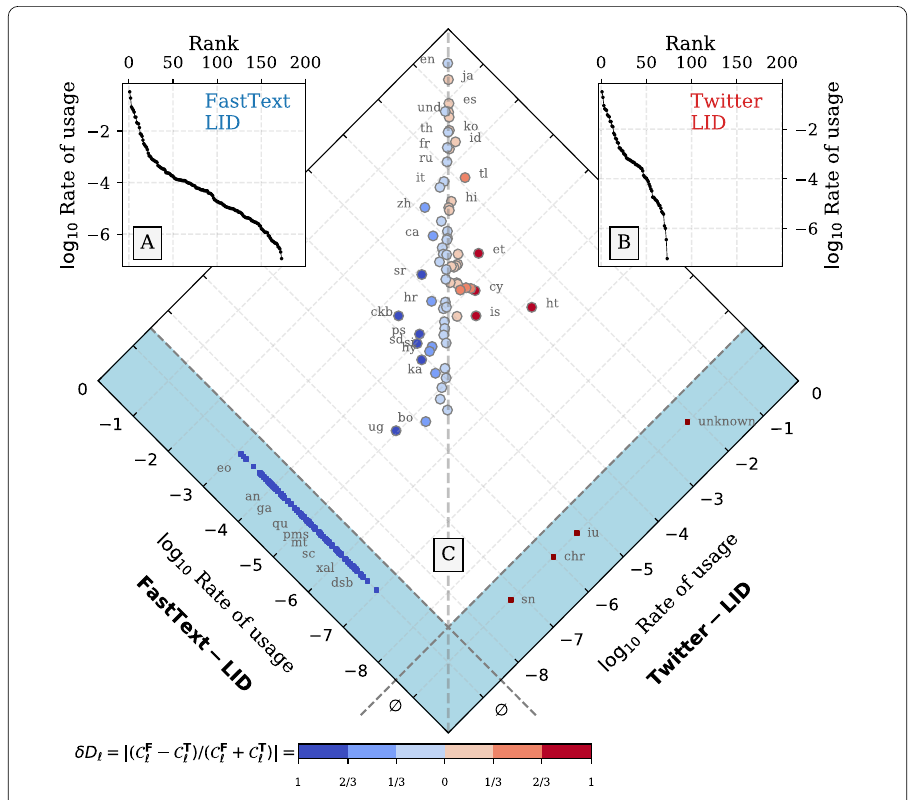
Figure 8 Language Zipf distributions. ( A ) Zipf distribution [143] of all languages captured by FastText-LID model. ( B ) Zipf distribution for languages captured by Twitter-LID algorithm(s). The vertical axis in both panels reports rate of usage of all messages p t , (cid:2) between 2014 and 2019, while the horizontal axis shows the corresponding rank of each language. FastText-LID recorded a total of 173 unique languages throughout that period. On the other hand, Twittert-LID captured a total of 73 unique languages throughout that same period, some of which were experimental and no longer available in recent years. ( C ) Joint distribution of all recorded languages. Languages located near the vertical dashed gray line signify agreement between FastText-LID and Twitter-LID, specifically that they captured a similar number of messages between 2014 and end of 2019. Languages found left of this line are more prominent using the FastText-LID model, whereas languages right of the line are identified more frequently by Twitter-LID model. Languages found within the light-blue area are only detectable by one classifier but not the other where FastText-LID is colored in blue and Twitter is colored in red. The color of the points highlights the normalized ratio difference δ D (cid:2) (i.e., divergence) is the number of messages captured by FastText-LID for language (cid:2) , between the two classifiers, where C F (cid:2) and C T is the number of messages captured by Twitter-LID for language (cid:2) . Hence, points with darker colors (cid:2) indicate greater divergence between the two classifiers. A lookup table for language labels can be found in the Table 1, and an online appendix of all languages is also available here: http://compstorylab.org/storywrangler/papers/tlid/files/fasttext_twitter_timeseries.html